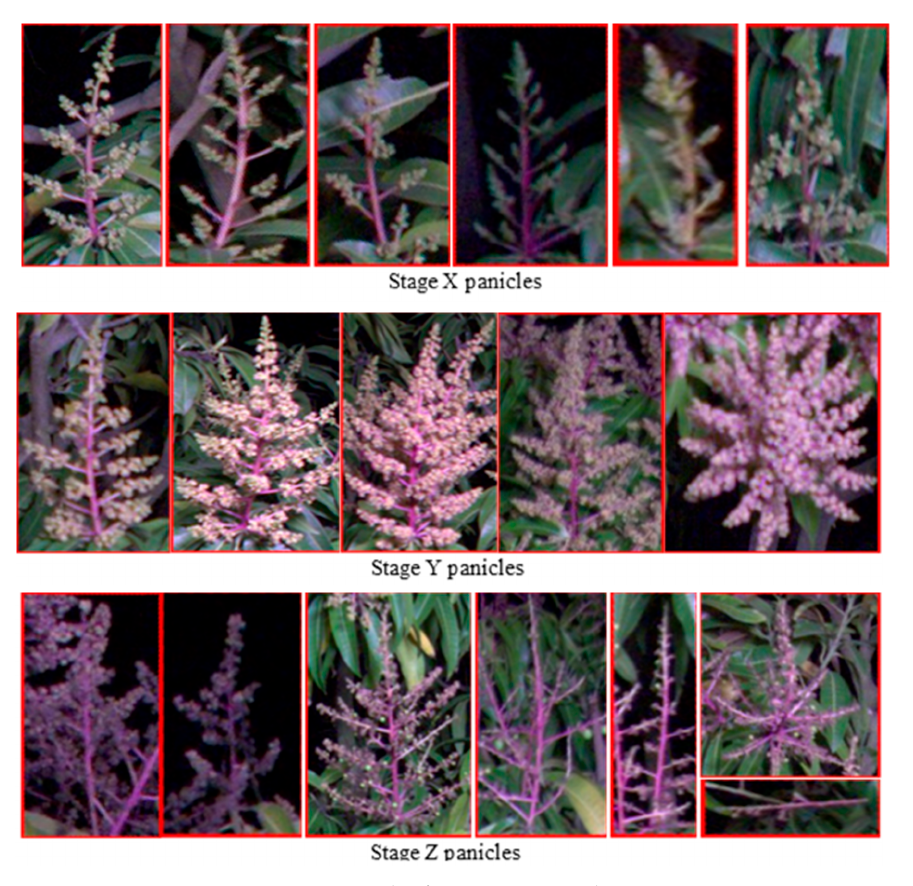
Figure 2. E xamples for stages X to Z, by rows . Figure 2. Examples for stages X to Z, by